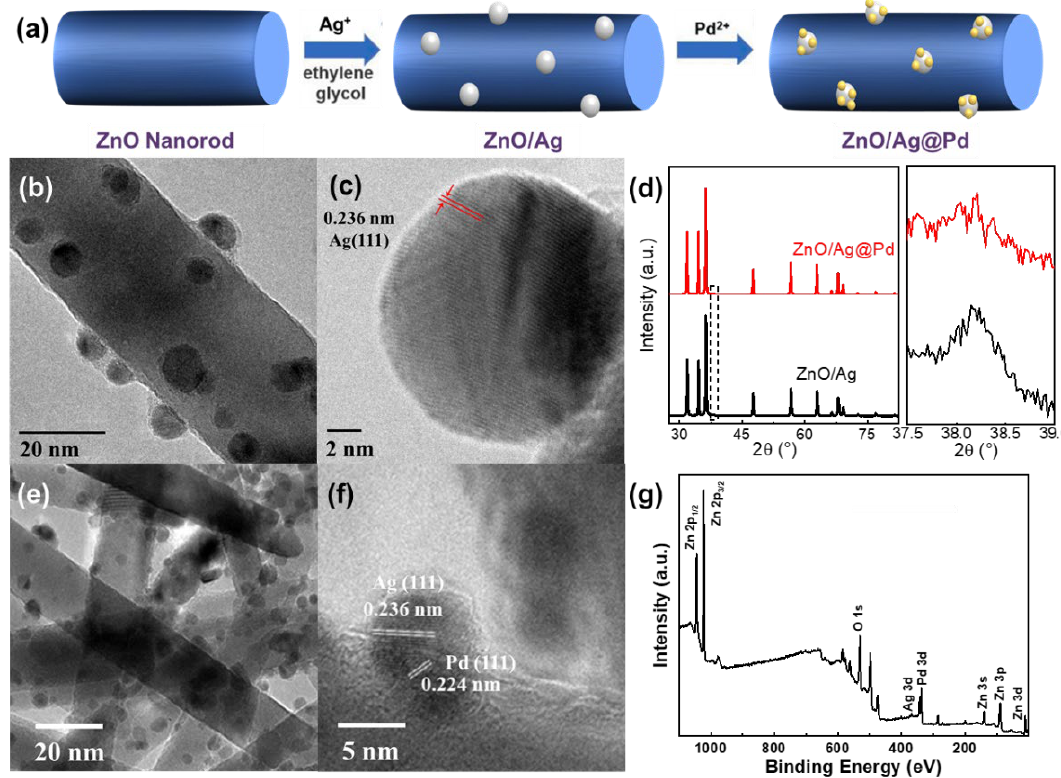
Figure 4. ( a ) Schematic illustration for the fabrication of ZnO/Ag@Pd. ( b , c ) TEM image of ZnO/Ag. ( d ) XRD patterns of ZnO/Ag and ZnO/Ag@Pd. ( e , f ) TEM image of ZnO/Ag@Pd. ( g ) Overall XPS spectra of ZnO/Ag@Pd.